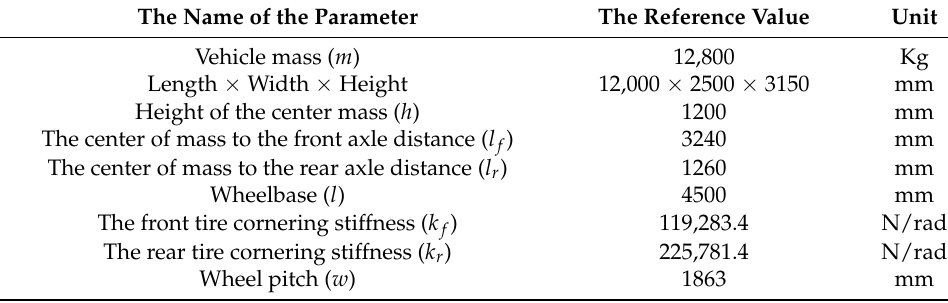
Figure 3. MATLAB/Simulink-TruckSim co-simulation control strategy. Table 1. Reference values for some parameters of an electric bus.